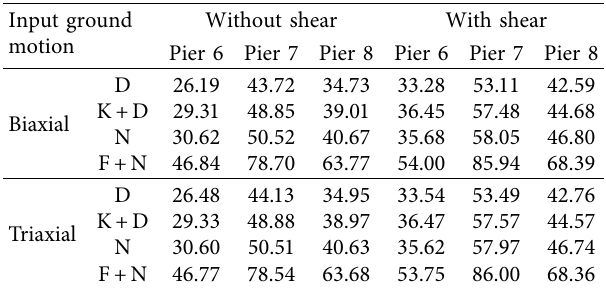
Figure 6: Comparison of ductility demand under N and F+ N earthquakes. (a) Under biaxial input ground motions. (b) Under triaxial input ground motions. Table 3: Maximum transverse displacement under bi- and triaxial input ground motions (in